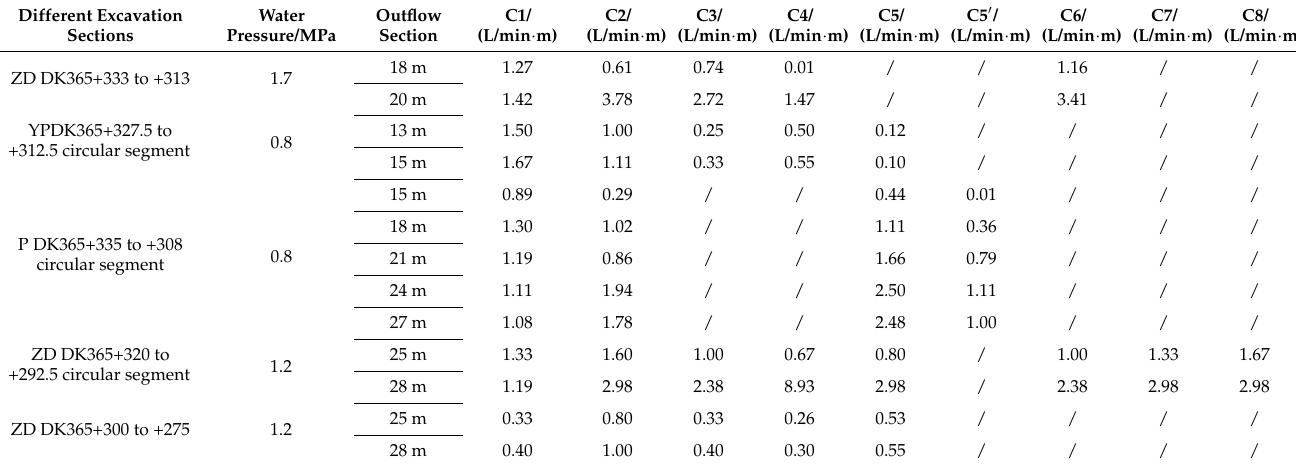
Table 10. Actual measurement data of different sections of Qiyue Mountain Tunnel.